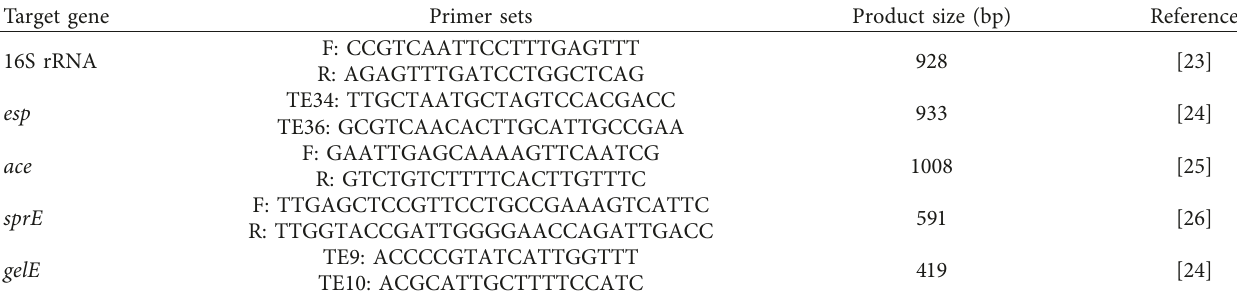
Table 2: Primers and PCR conditions used for the 16S rRNA and virulence genes. Target gene Primer